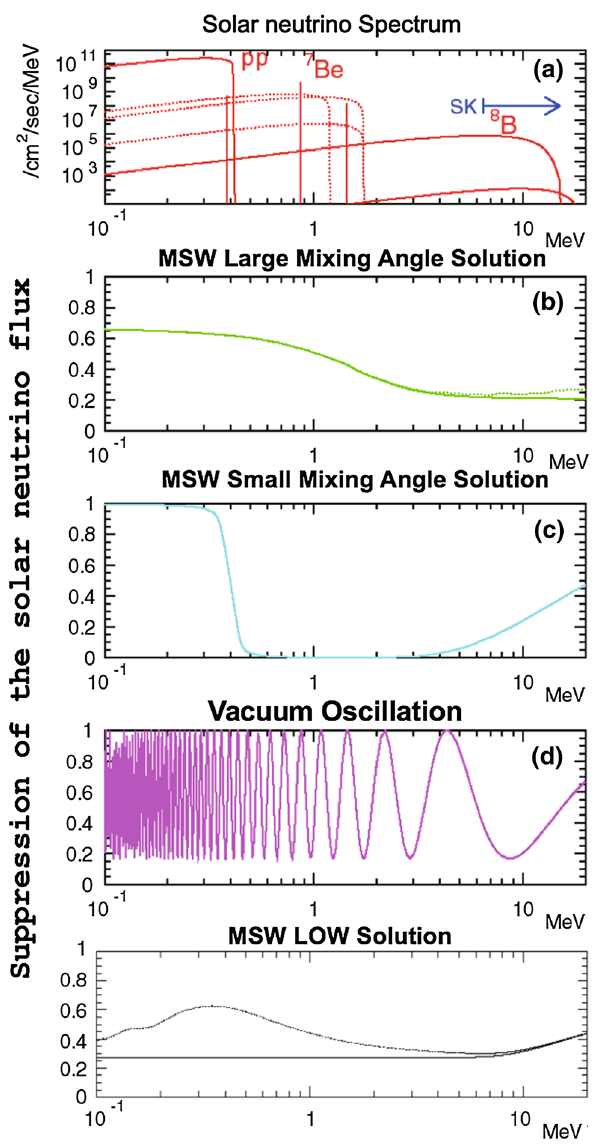
Fig. 9 The energy spectra of the four possible solutions. The small mixing angle solutions and the vacuum solutions show strong distortion of the energy spectrum and the large mixing angle solution gives a day/night flux difference. A seasonal flux difference can be seen for the vacuum